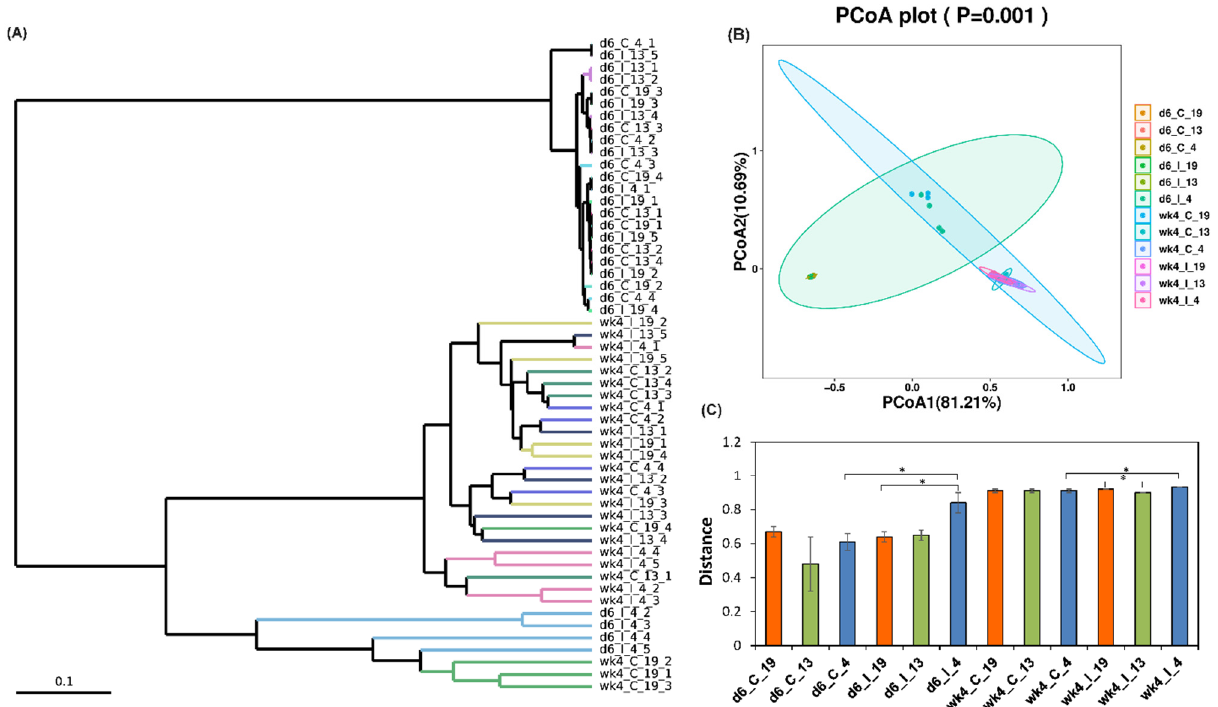
Figure 3. Beta diversity of beet curly top virus (BCTV) − susceptible and BCTV − resistant sugar beet genotypes with and without BCTV infection at early (day 6; d6) and late (week 4; wk4) time points. ( A ) Cluster dendrogram of different treatments, ( B ) principal coordinate analysis (PCoA), and (C) comparison of weighted UniFrac distances within and between control ( C ) and BCTV − infected (I) sugar beet susceptible (19) and resistant (13, 4) genotypes at early and late time points (* p < 0.05). C = uninfected control, and I = BCTV-infected. The data are mean ± standard error of four replicates (uninfected control) and five replicates (infected).